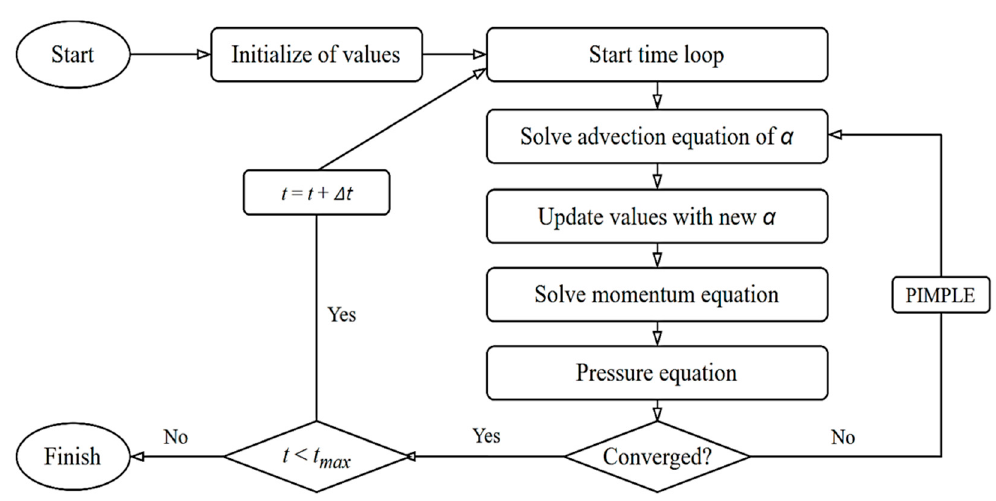
Figure 3. Flow chart of the volume of fluid (VOF) method.